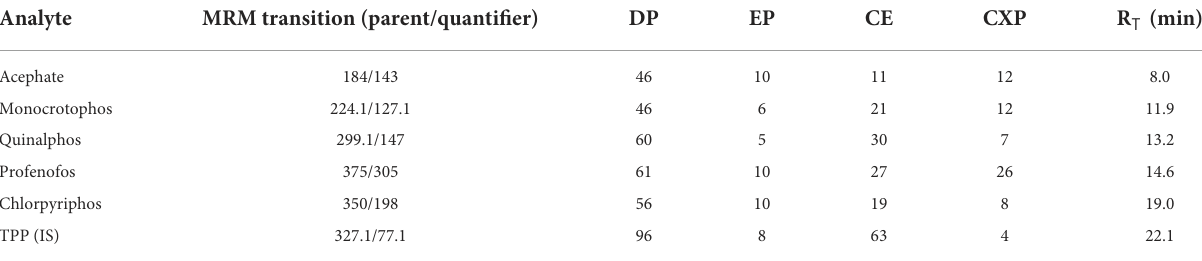
TABLE 2 Optimized MS/MS parameters for organophosphorus compounds in multiple reaction monitoring (MRM) mode using different energy profiles.